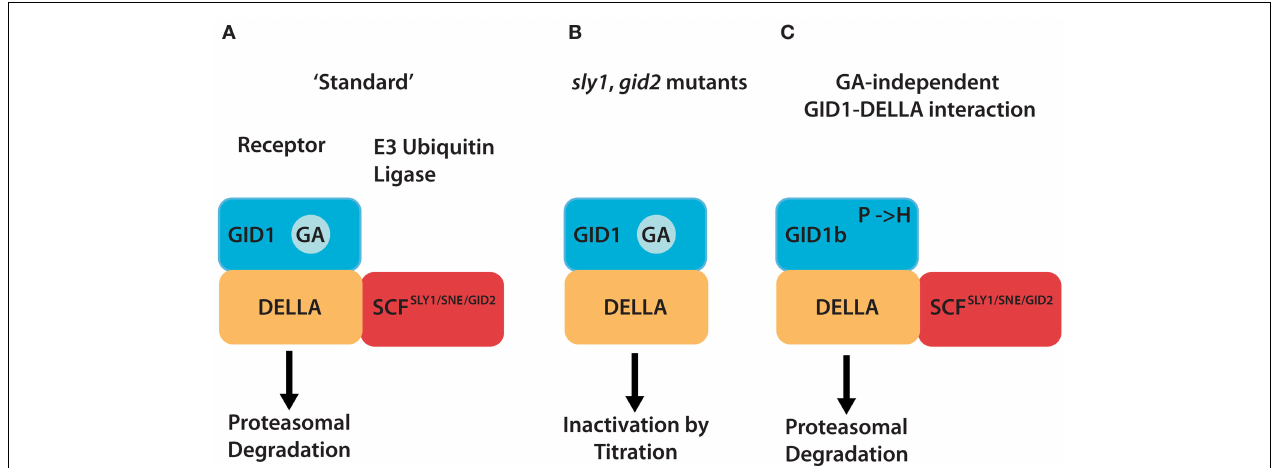
and relieve DELLA-imposed growth restraints. (C) GID1 variants with a substitution of a conserved proline (P) residue can interact with DELLAs in a GA-independent manner and promote GA signaling independent from the hormone. Arabidopsis GID1b is a naturally occurring GID1 protein that has a histidine instead of the proline (P → H). GID1 mutant analyses additionally revealed that P → A or P → S substitutions render GID1